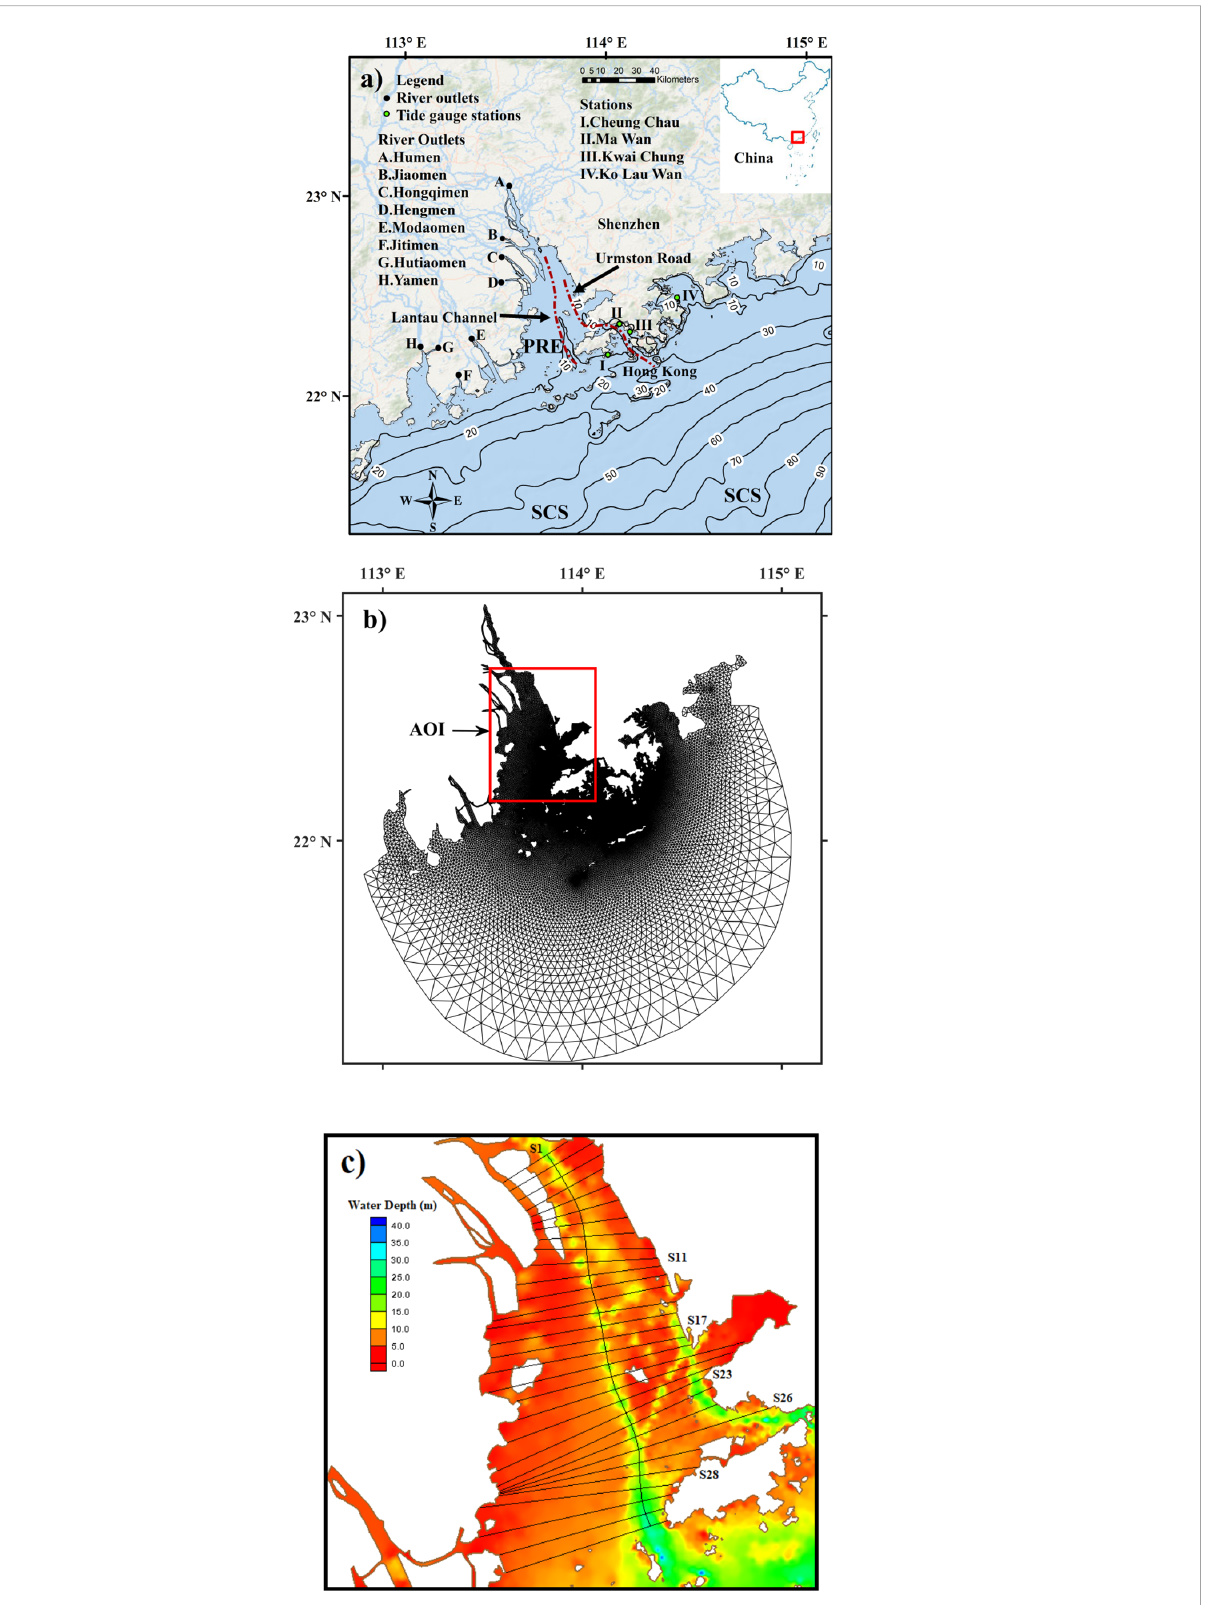
FIGURE 1 (A) Map of the Pearl River Estuary (PRE) with topographic features and isobaths (in meters), including northern part of the South China Sea. (B) Horizontal grids of Finite-Volume Coastal Ocean Model (FVCOM) model showing area of interest (AOI). (C) Water depth inside the PRE and the distribution of the PRE sections, among which S1 shows the approximate shape of the Lantau Channel, whereas the other sections are normal to S1 and are named in an increasing sequence from north to